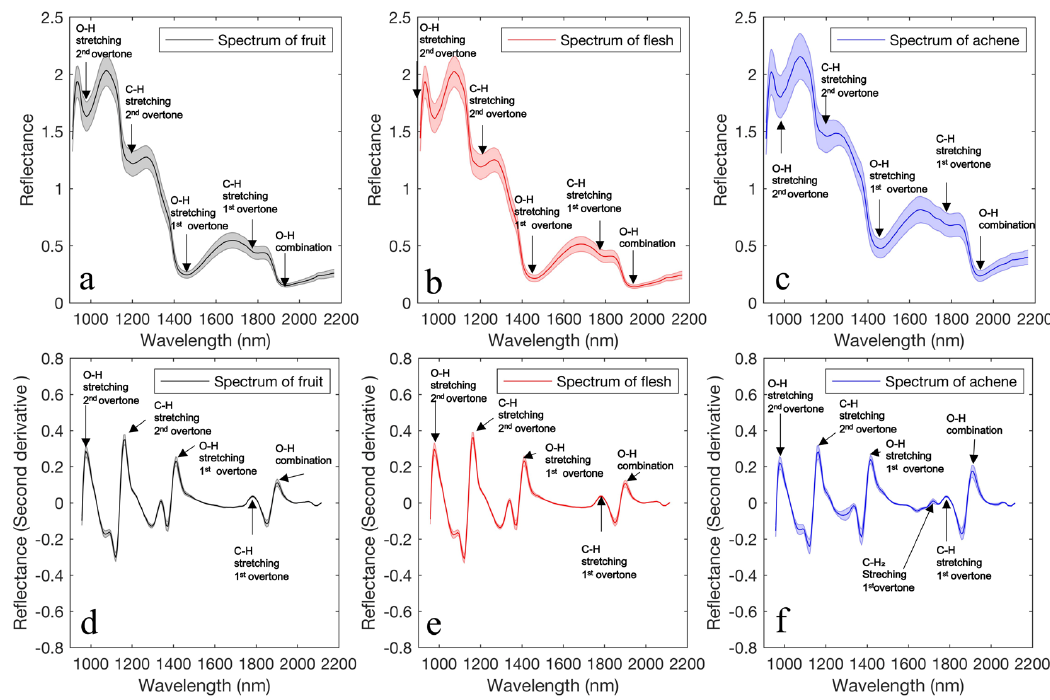
Figure 7. Average reflectance spectra (the spectral range is the mean ± standard deviation) of: ( a ) fruit, ( b ) flesh, and ( c ) achene. Second derivative average reflectance spectra (Spectral range is mean ± standard deviation) of: ( d ) fruit, ( e ) flesh, and ( f ) achene in strawberries.